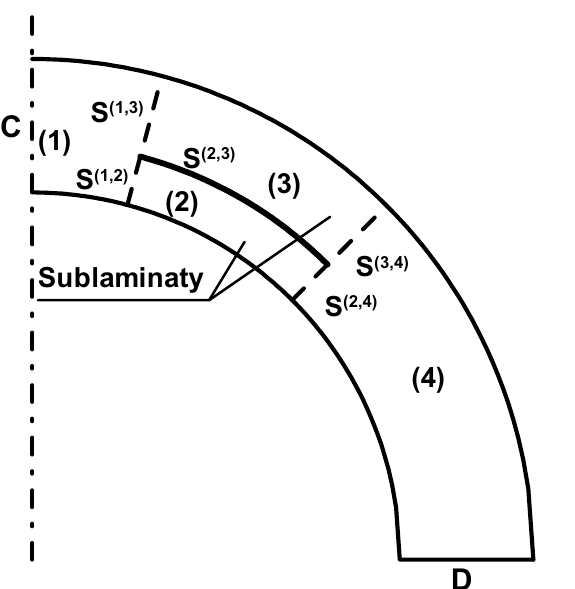
Figure 7. The effects of the delamination length a on the buckling pressures p.